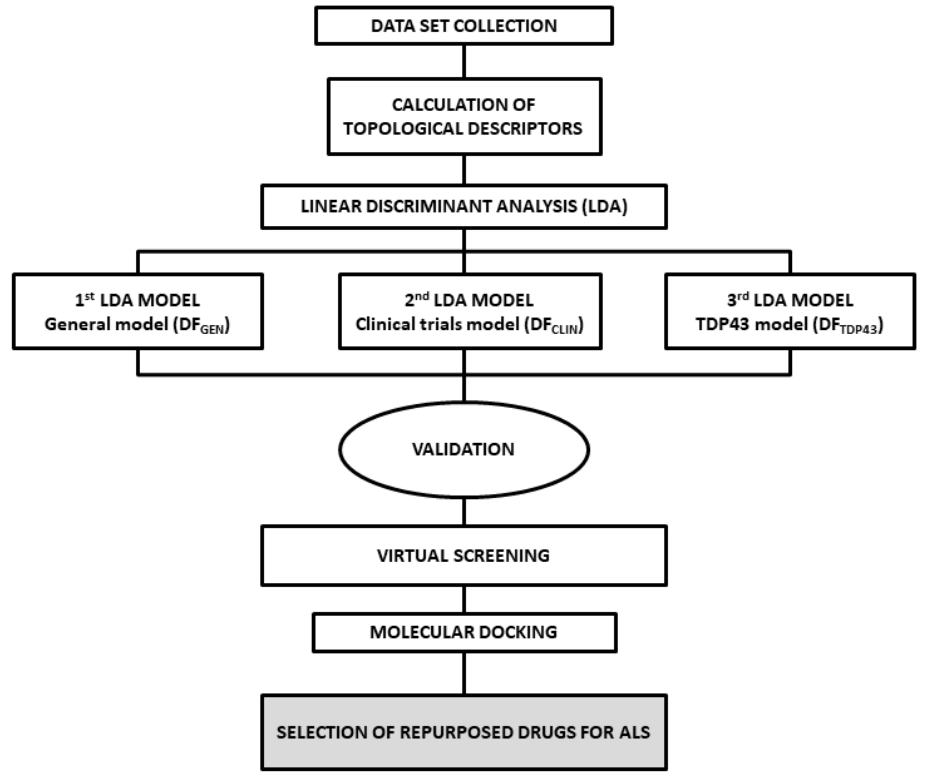
Figure 8. Search algorithm used to develop the in silico strategy for the repositioning of potential ALS drugs. ALS